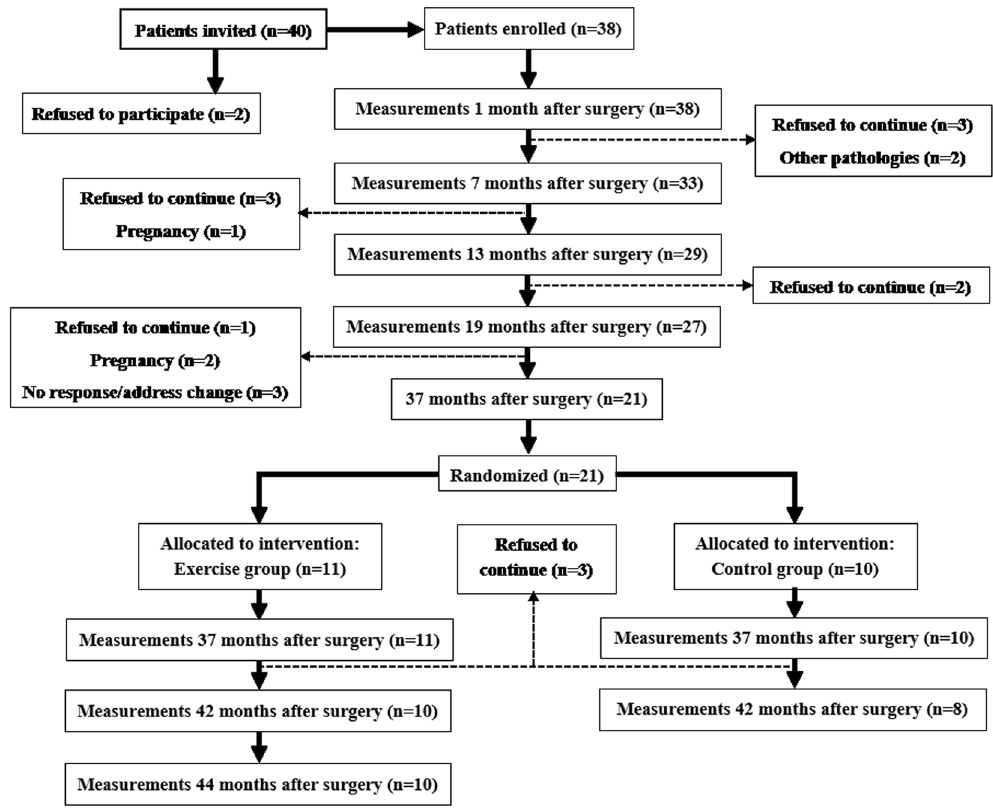
Figure 1. CONSORT flow diagram during the study. Two participants from the control group were lost, and one participant in the experimental group failed to complete the program due to a lesion unrelated to the